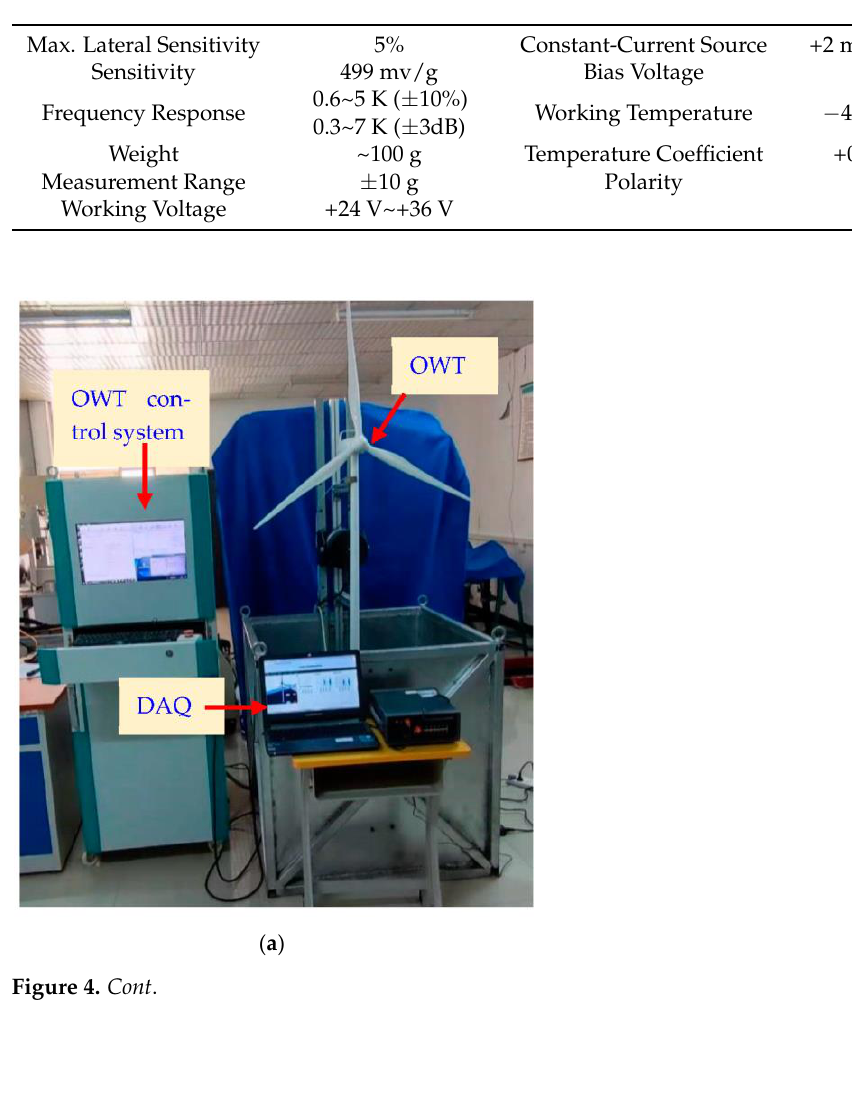
Table 1. Parameters of the acceleration sensor.